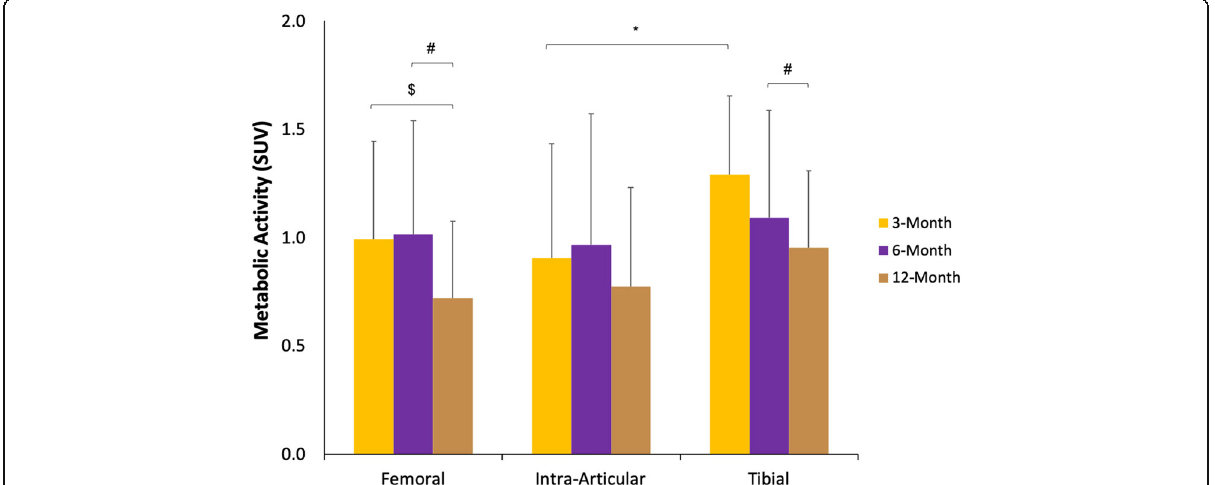
Fig. 3 Whole Region SUV. Graph displaying the metabolic activity (y-axis) of the femoral tunnel, intra-articular graft, and tibial tunnel (x-axis). The metabolic activity of the whole regions is differentiated into the three-month (yellow), six-month (purple), and 12-month (brown) time periods. *, $ , and # denote significance ( p < 0.05) between the tibial tunnel and intra-articular graft, three-month and 12-month time-periods, and 6-month and 12-month time-periods, respectively